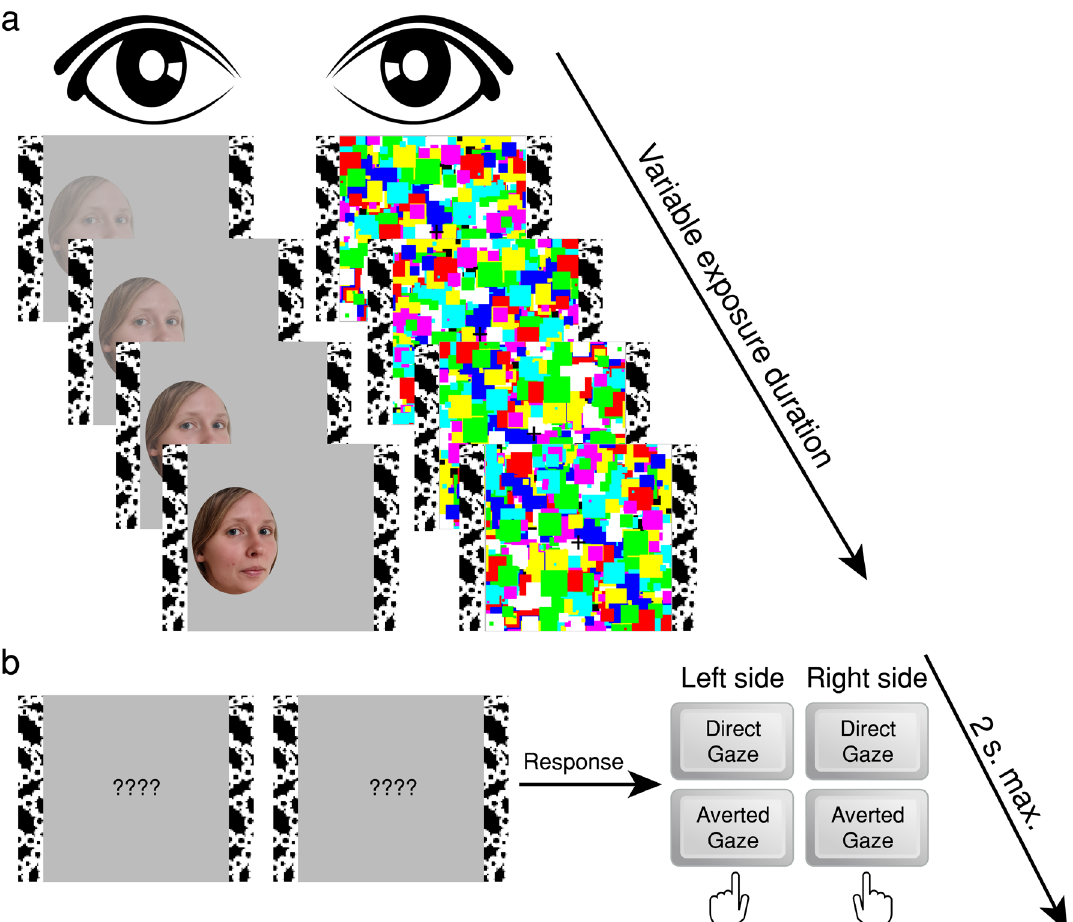
Figure 3. Schematic description of a trial in Experiment 2. ( a ) Stimulus presentation. Stimuli were presented for one of seven possible durations (500–5695 ms, equally spaced on a log scale). The contrast of the target image increased linearly from zero to 100% over the first second and then remained unchanged until the end of the trial. ( b ) Detection/identification response. Immediately following stimulus offset, a response cue was presented binocularly. Participants provided a single response to indicate both on which side of fixation the face had been shown and whether its gaze was direct or on the right. To determine sensitivity to the presence of a face making eye contact (gaze direction identification d’), hits were defined as trials in which a direct-gaze face was shown and reported, and FAs as trials in which an averted-gaze face was shown but a direct-gaze face was reported (note that for the sake of simplicity, we refer to this measure as gaze direction identification d’; this denotes identification in the limited sense of identifying a specific detail within the stimulus—whether the gaze is direct or averted—rather than identifying who the person is). For each measure, we calculated d’ by subtracting the Z-transformed FA rate from the Z-transformed hit rate. Because in SDT terms the location task is a 2-alternative forced-choice task (requiring a decision on which of two sources of information contains the signal), for this task we divided d’ by the square root of 2 67,68 . We also calculated criterion measures ( C ) for both tasks, by multiplying each task’s sum of Z-transformed hit and FA rates by −0.5 68 . For the location task, this measure estimates each participant’s bias to respond left or right (henceforth referred to as response bias), with more positive values indicating a greater bias to respond “left”; however, as the direction of biases may vary across participants (and cancel out in averaging), we converted response bias